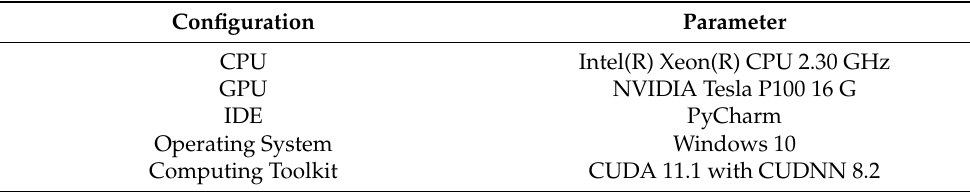
Table 3. Configuration of the computer in this study.